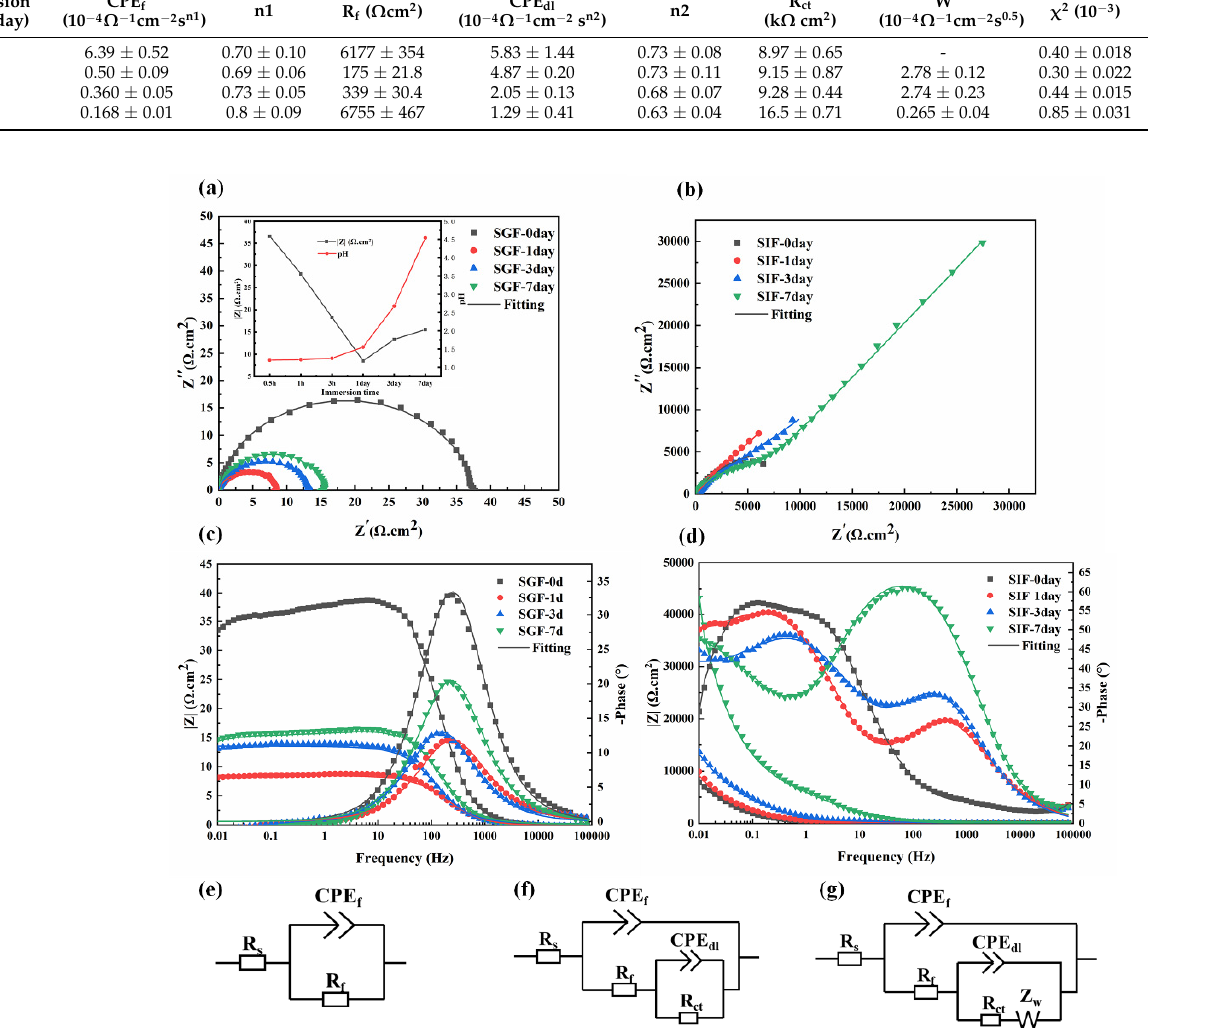
Figure 10. EIS of Zn–0.4Li immersed for different times: ( a , b ) Nyquist plots and ( c , d ) Bode plots. ( a , c ) For SGF, ( b , d ) for SIF. Diagrams ( e – g ) show the equivalent circuits used for EIS data. Circuit ( e ) was used to fit the EIS data obtained in SGF at all intervals, and ( f ) was used to fit the EIS data obtained in SIF on day 0 and ( g ) for 1, 3, 7 days. The insert shows the change in the values of |Z| and pH along with immersion time in ( a